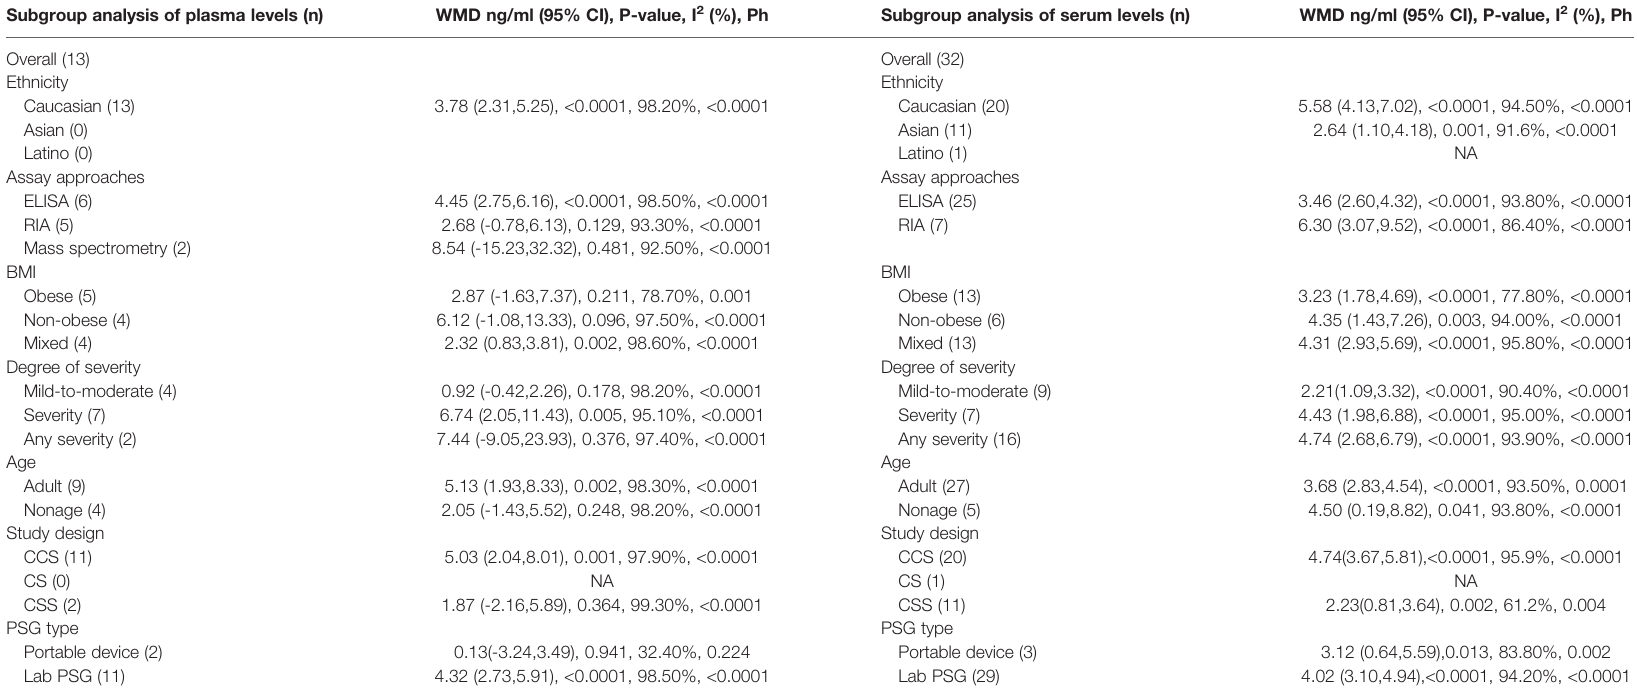
TABLE 3 | Subgroup analyses of leptin levels in OSAS and controls. Subgroup analysis of plasma levels